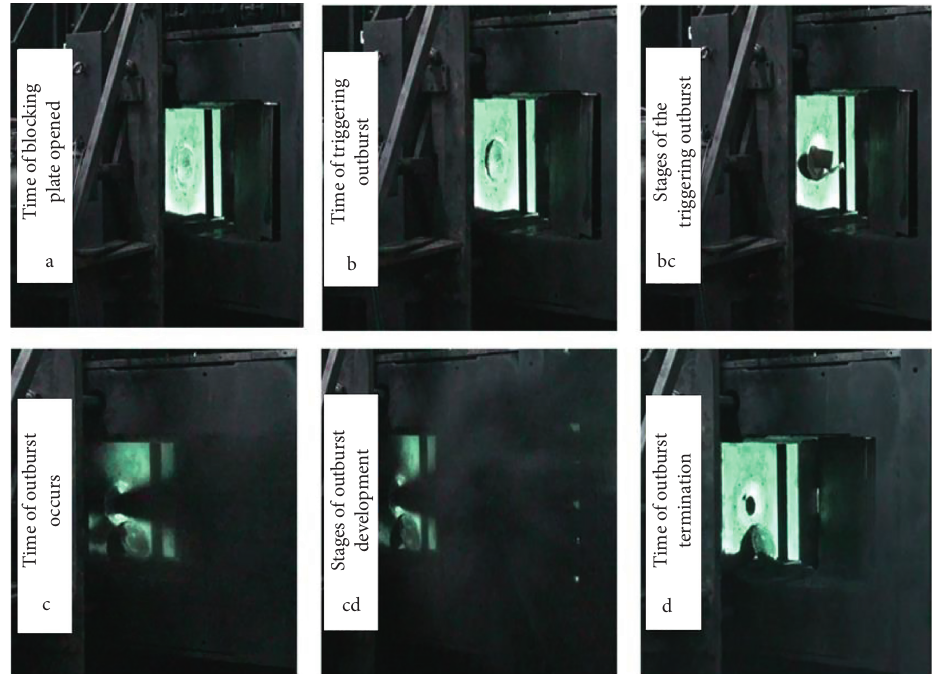
Figure 9: Video screenshots of the delay outburst caused by gas accumulation in front of the working